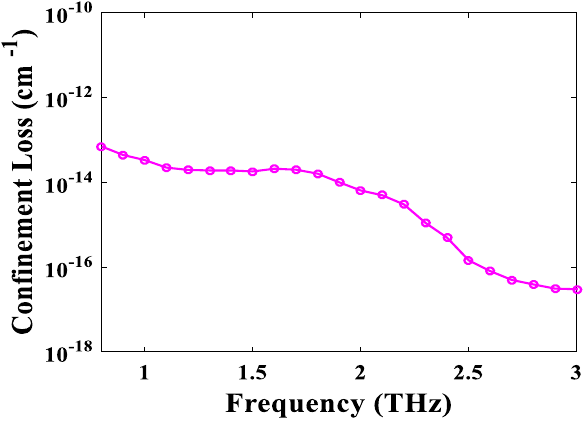
Fig. 9 Variation of Confinement Loss with respect to frequency at THz region at optimum